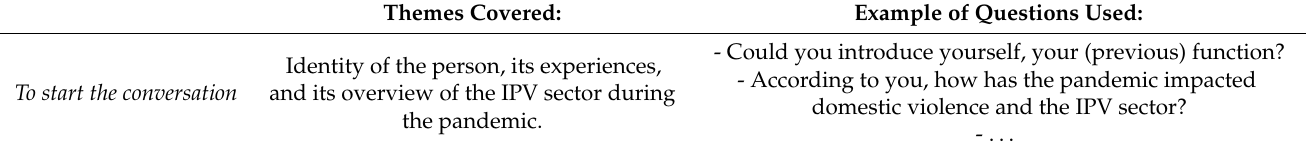
Table 3. Core questions of the interview